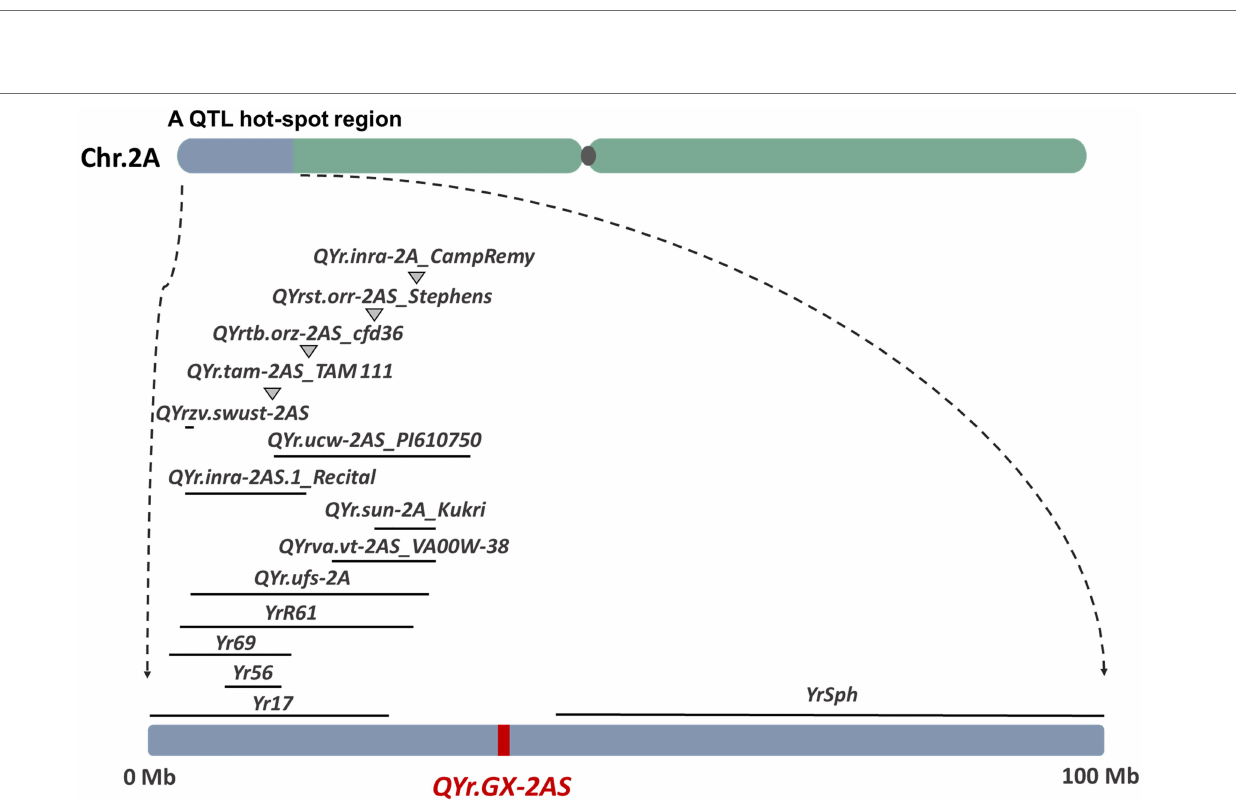
FIGURE 5 | Stripe rust response of the near-isogenic lines with mixture Pst at the adult-plant stage in the field (A) , genetic map of chromosomes 2AS showing locations of stripe rust resistance genes QYr.GX-2AS based on the heterogeneous inbred family (HIF) population (B) , predicted genes in IWGSC RefSeq v1.1, highlight in black showed non-synonymous variants between Gaoxianguangtoumai (GX) and Chinese Spring in the exon regions (C) .